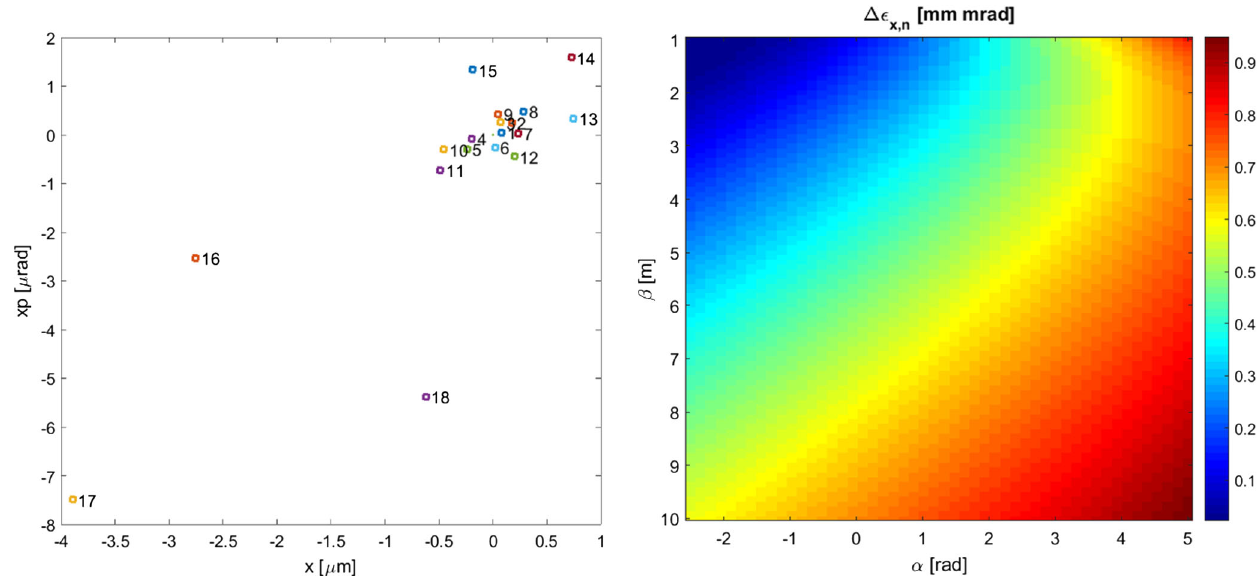
FIG. 4. Left: particle transverse displacement in the horizontal phase space due to CSR energy kicks in the FODO-compressive arc dipoles of Fig. 2. The numbers correspond to CSR kicks at the eighteen consecutive dipoles. Right: normalized projected horizontal emittance growth as a function of Twiss parameters at the end of the beam line, calculated with the CSR kick model. Compressive arc and beam parameters used for this study are listed in Table